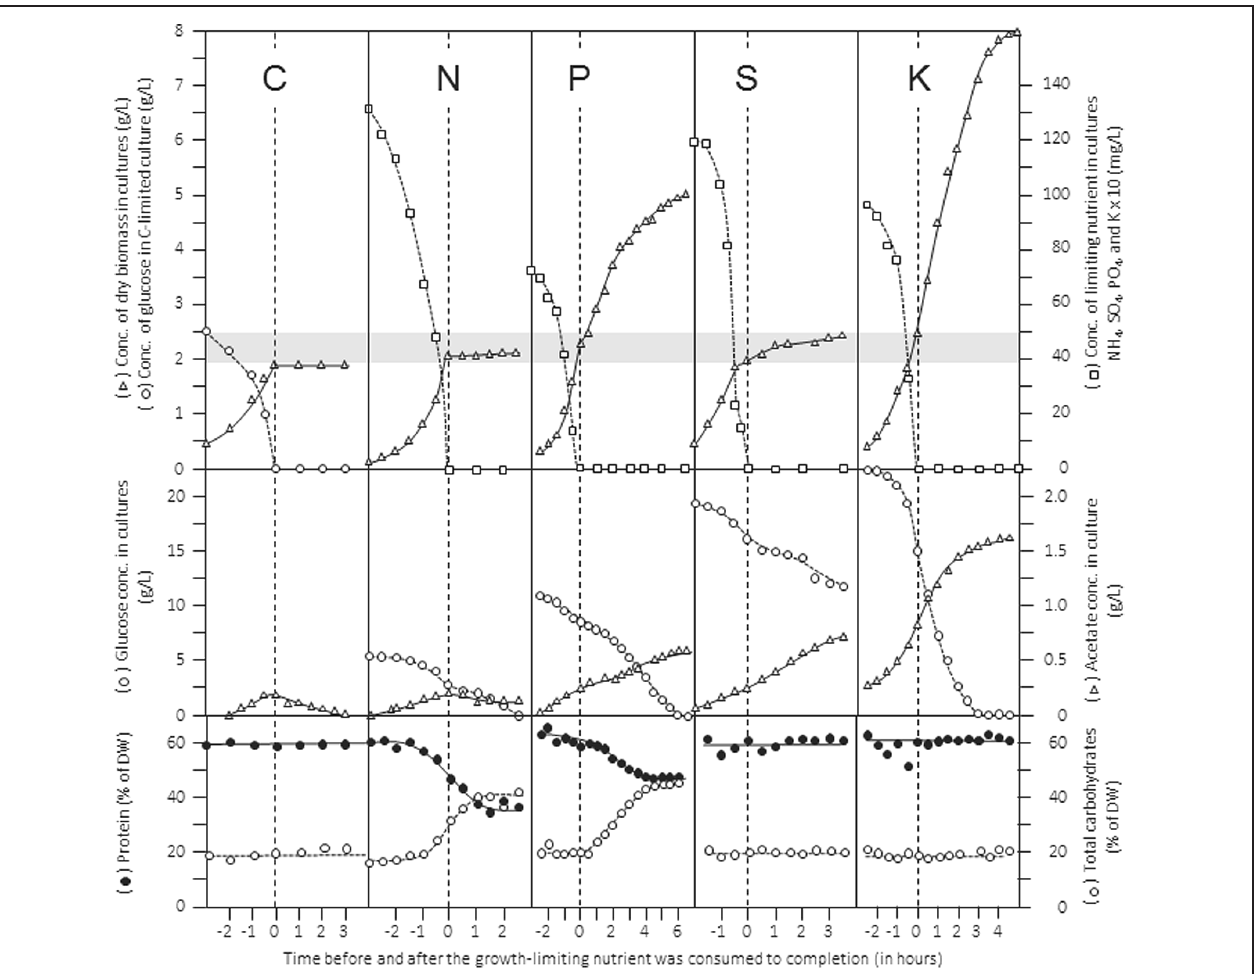
FIGURE 2 | Patterns of growth, nutrient consumption, product formation and gross cellular composition during batch growth of Klebsiella pneumoniae in a defined mineral medium limited by different nutrients. The limiting nutrients were carbon (glucose), nitrogen (NH 4 + ), phosphorus (PO 43 − ), sulfur (SO 42 − ), and potassium (K + ),